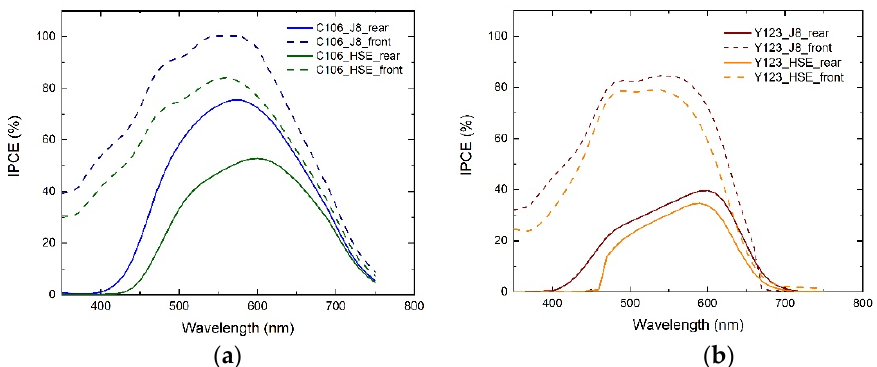
Figure 4. IPCE spectra of C106 and Y123 device. Cell were measured in a black background: ( a ) C106 device with J8* and HSE electrolytes, front and rear side; ( b ) Y123 device with J8* and HSE electrolytes, front and rear side.